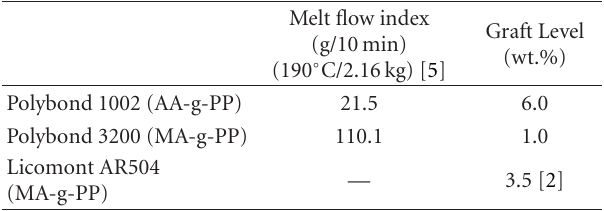
Table 1: Melt flow index and graft level of acrylic-acid and maleic- anhydride-grafted polypropylene